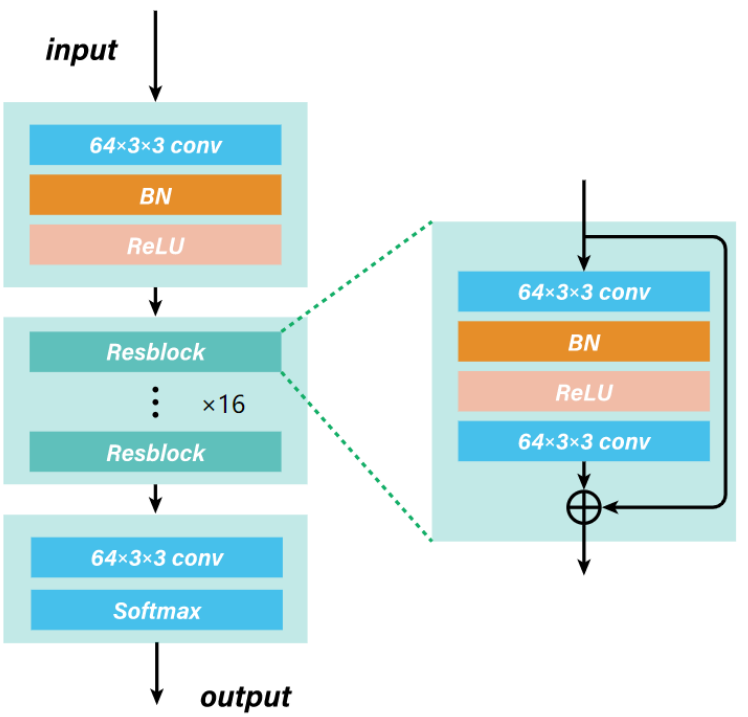
Figure 3. Details of the kernel module and noise module. The module consists of head, body and tail parts. ⊕ means element-wise addition.